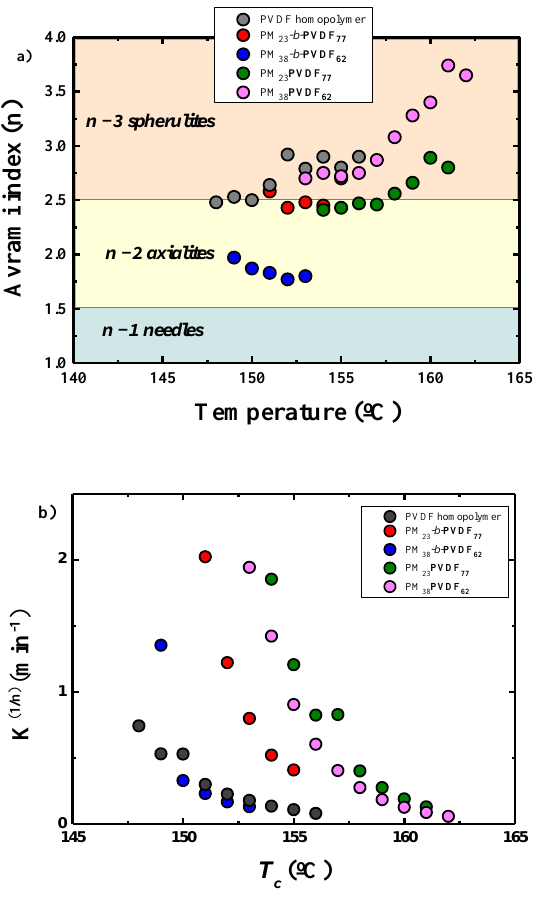
Figure 11. ( a ) PVDF Avrami index values for all the temperatures used in the isothermal crystalliza- tion and ( b ) isothermal crystallization rate obtained by the Avrami